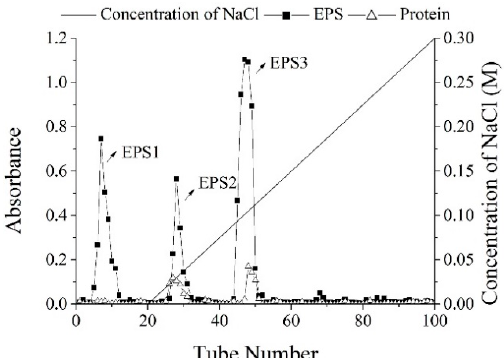
Figure 1. The elution curve of crude exopolysaccharide (EPS) on DEAE-52. The carbohydrates were detected via UV absorption at 490 nm, and proteins were detected at 280 nm. The eluent solvents were distilled water and a linear gradient of NaCl from 0 to 0.3 M.